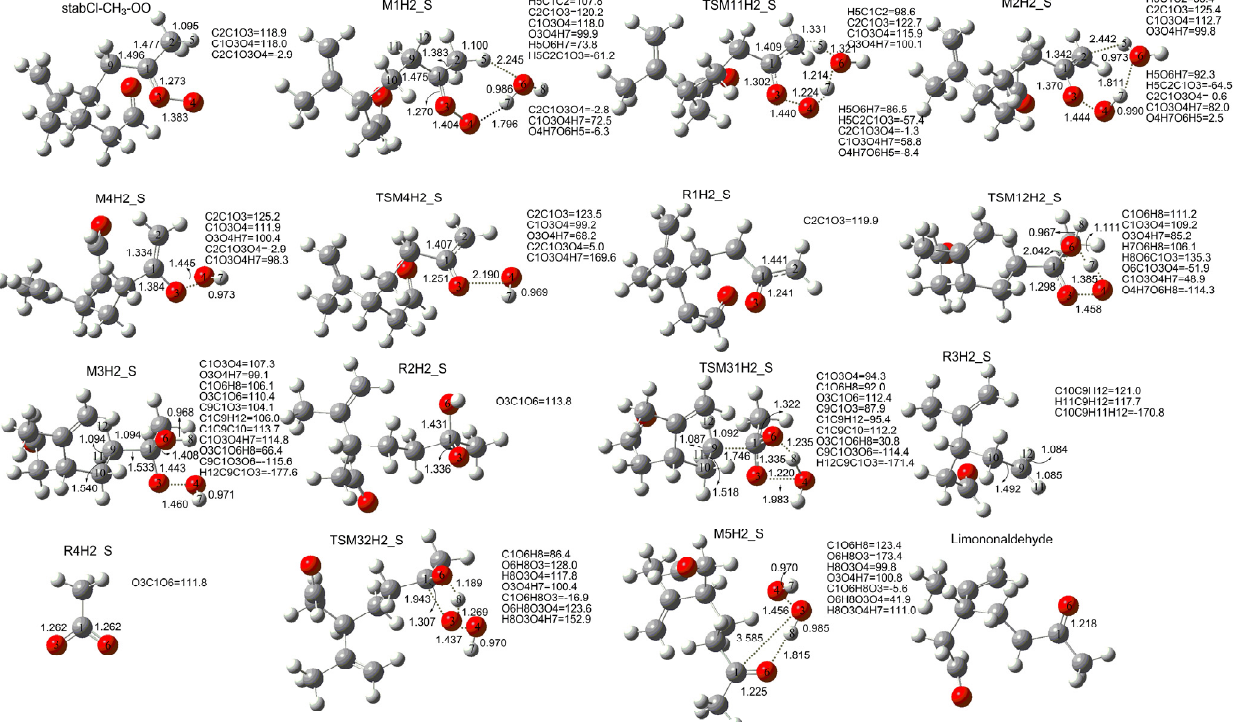
-OO + H O reaction 3 2